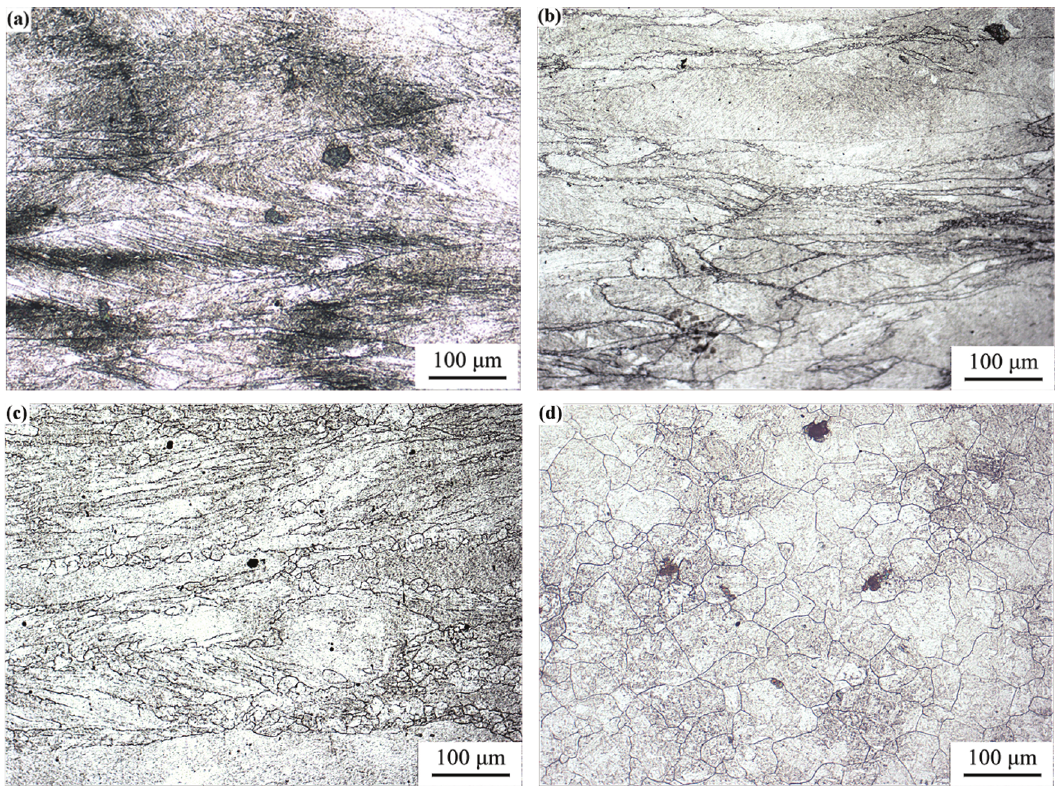
Figure 14: Metallographs showing the microstructure of AISI 410 stainless steel: (a) 1,000°C − 10 s − 1 ; (b) 1,200°C − 10 s − 1 ; (c) 1,050°C − 1 s − 1 ; and (d) 1,200°C − 0.1 s − 1